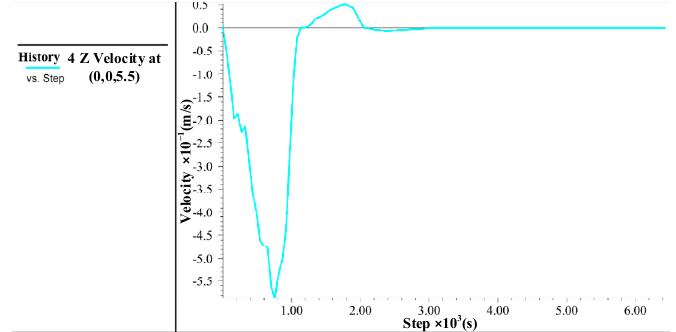
Figure 10. Nodal velocity at the bottom of the object.